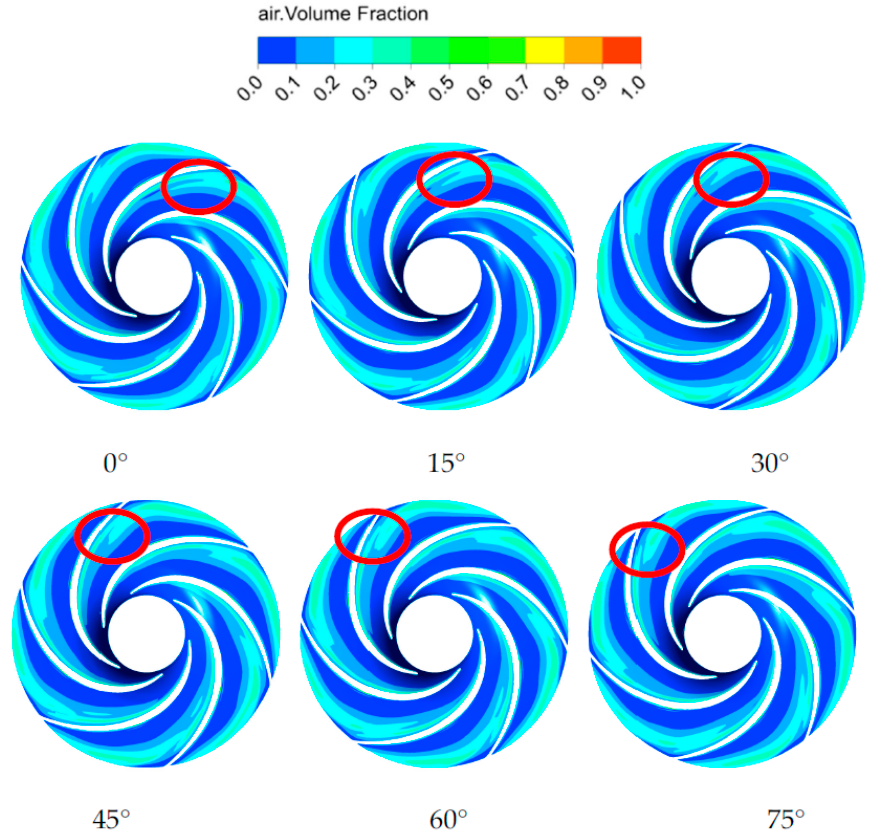
Figure 8. Transient distribution of the gas phase on the cross-section of the impeller under α = 0.1.